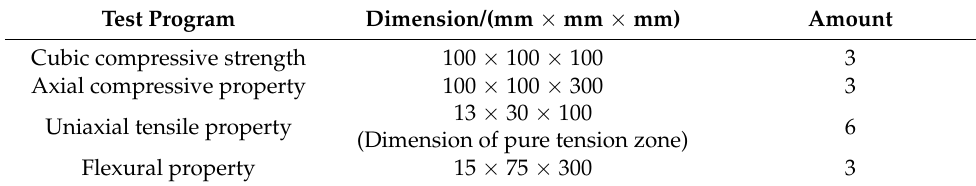
Table 3. Dimensions and amounts of HDC specimens.